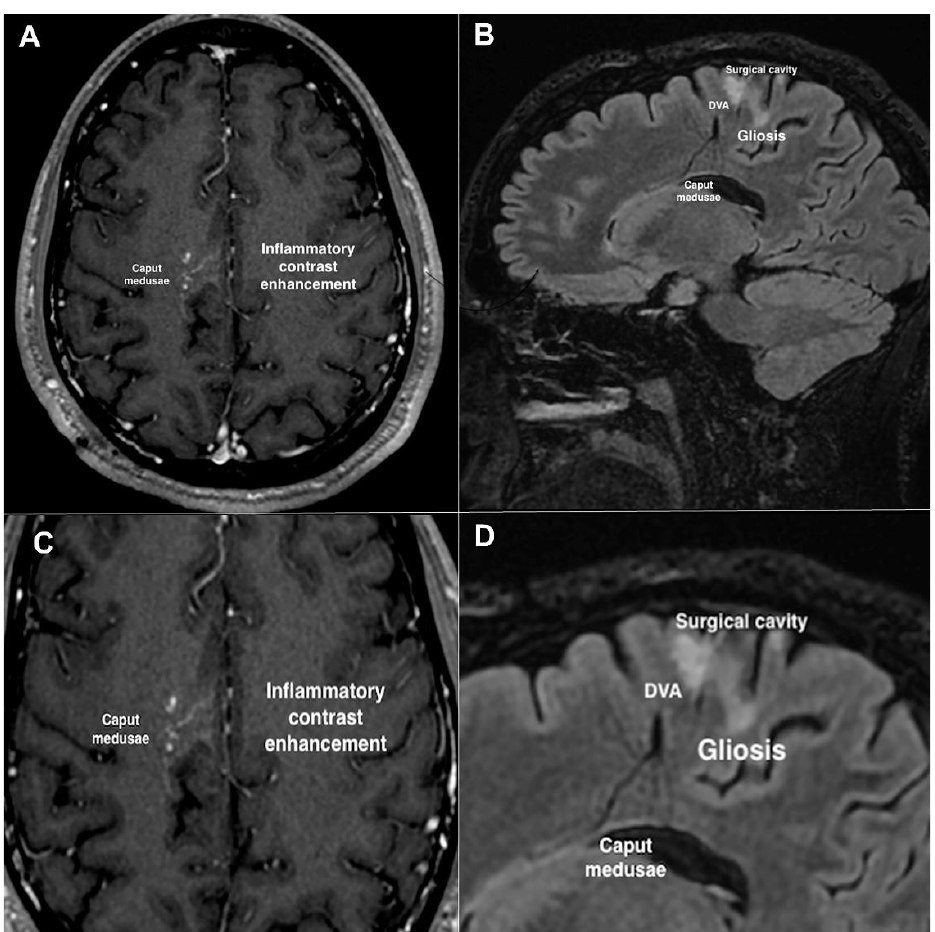
Figure 3. Contrast-enhanced MRI follow-up examination of the patient’s brain at 1 year after CCM surgery. ( A , C ) T1-weighted axial image. ( B , D ) T2-FLAIR (fluid-attenuated inversion recovery) sagittal image. Contrast-enhanced images were obtained after injection of gadolinium as nontoxic paramagnetic contrast enhancement agent. ( C , D ) Magnified images of panels ( A , B ), respectively. Notice the presence of signal-intensity abnormalities in the bed of the DVA, including point-like contrast enhancements and hyperintense gliotic areas.